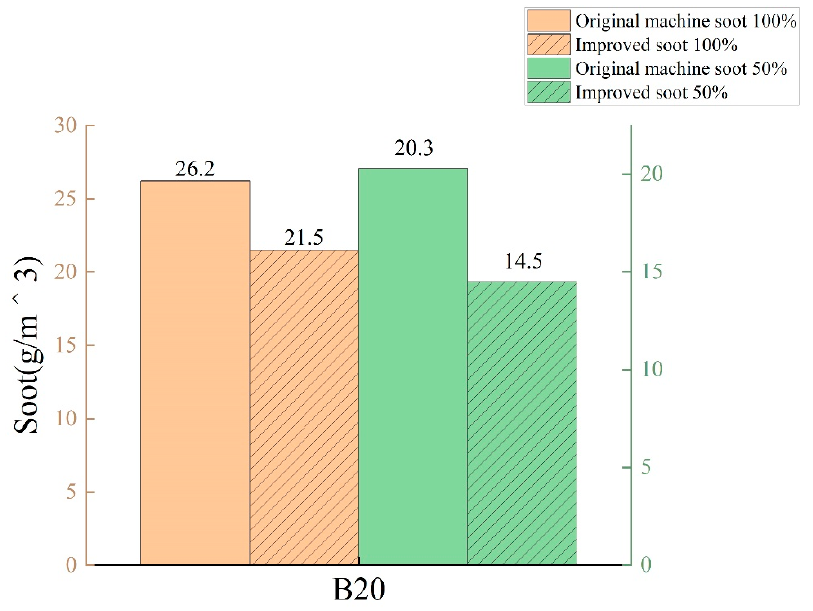
Figure 17. Comparison of improved soot emissions with original values at 100% and 50% load.